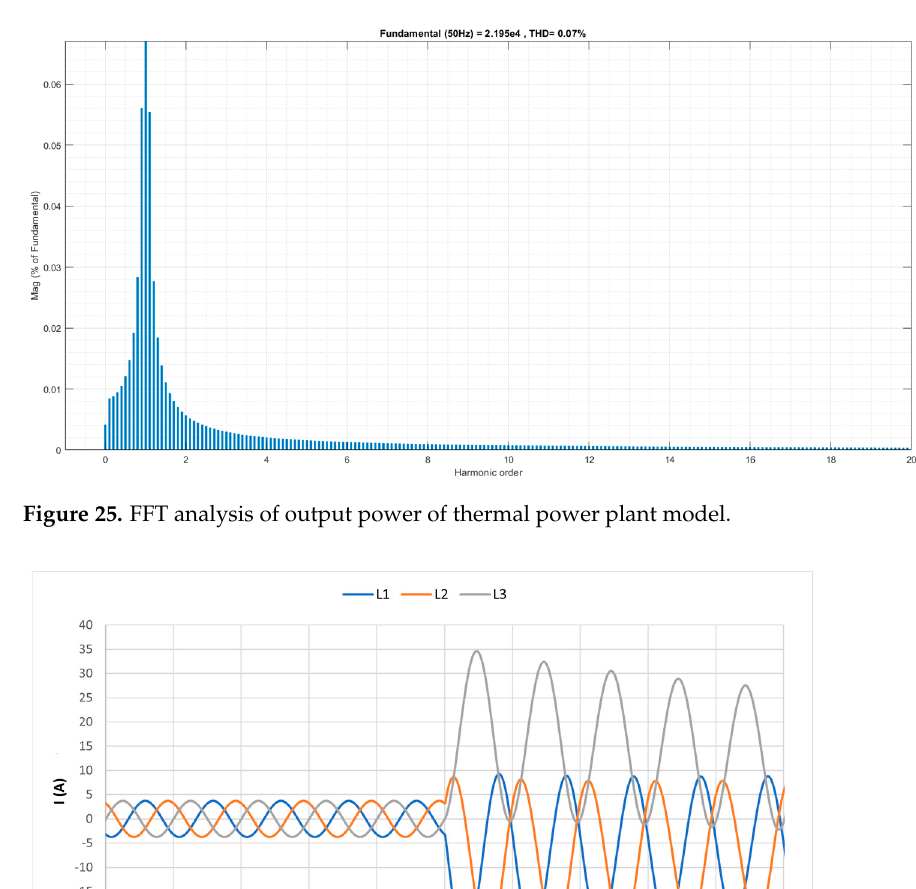
Figure 25. FFT analysis of output power of thermal power plant model.